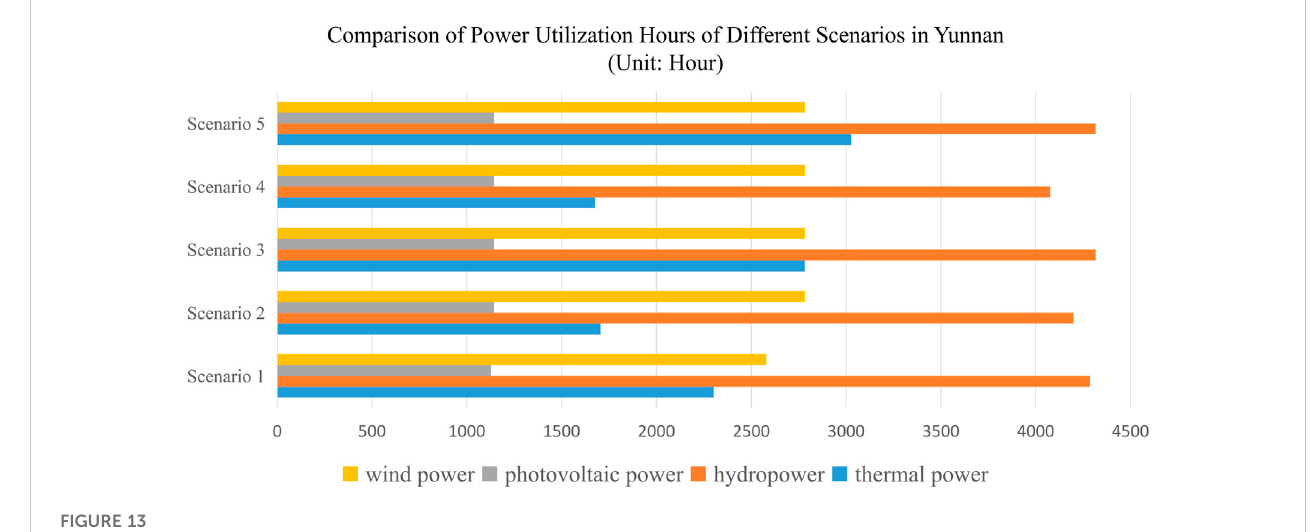
FIGURE 13 Comparison of power utilization hours of different scenarios in Yunnan.